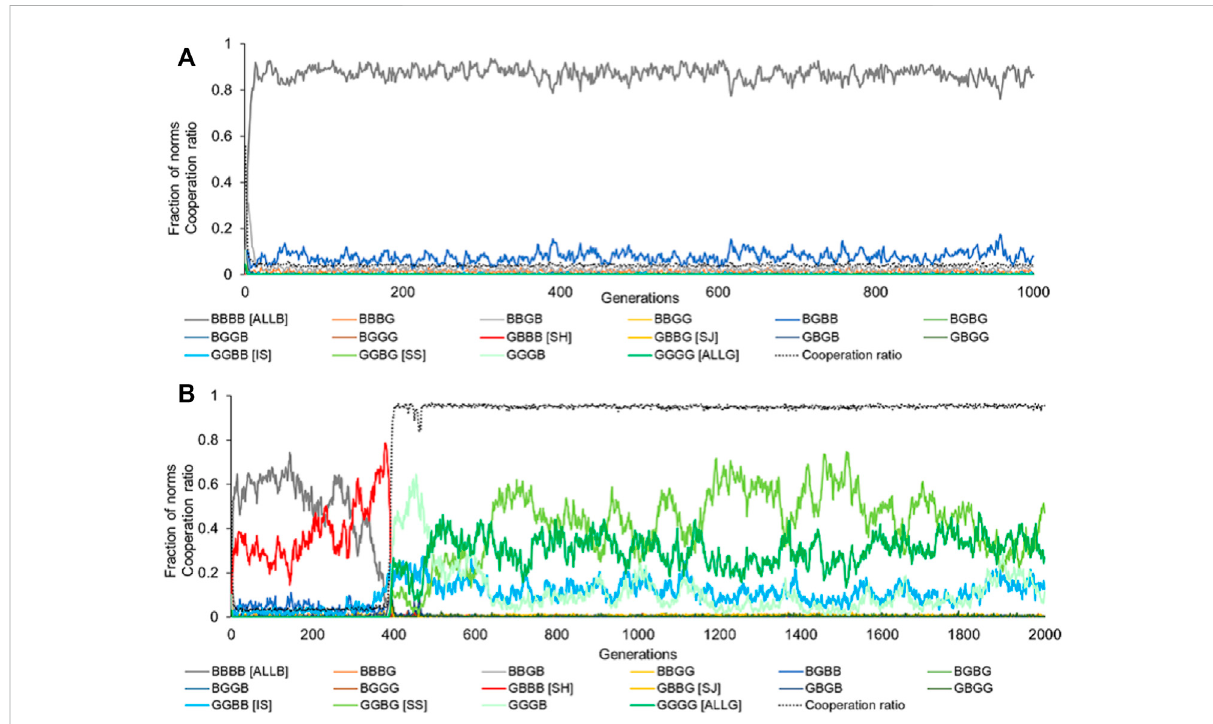
FIGURE 3 Pioneer norms analysis (A) and keystone norm analysis (B) regarding SH. The x -axis shows generations and the y -axis shows the fraction of norms and cooperation ratio. The solid line represents population of each norm and the black dotted line represents cooperation ratio. In